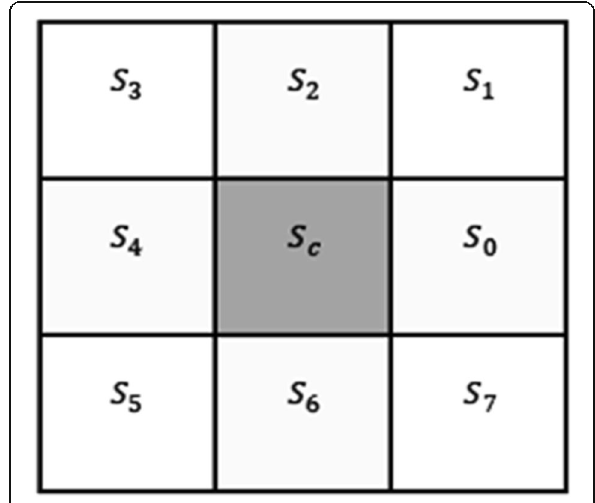
Fig. 8 The (8,1) local binary pattern used in Chang ’ s [3] scheme [3]